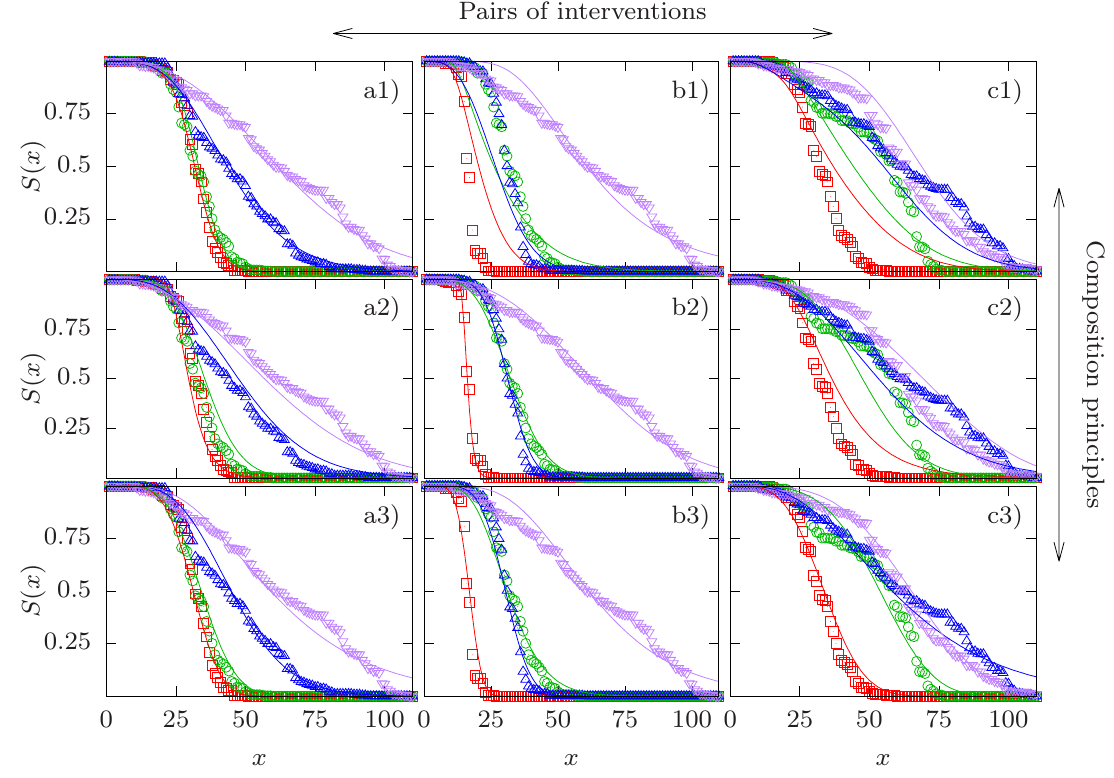
Figure 1. Comparison of experimental survival curves and model fits for three cases. Experimental survival curves are depicted by symbols and their respective fits by lines. Columns correspond to different pairs of interventions and rows correspond to different composition principles (CPs). Column a) shows the quadruple 1000 – 1011 , column b) the quadruple 0010 – 1011 , and column c) the quadruple 1010 – 1111 . Row 1) shows the competing risks CP, row 2) shows the generalized multiplicative CP, and row 3) shows the generalized scaling CP. Red squares represent the baseline curve, green circles and blue upward triangles display the two single interventions in the order of their position in the binary string (green circles first, blue upward triangles second), and purple downward triangles correspond to the combined interventions. The fits in panels a1), b2) and c3) have the best quality in their respective column in terms of their sum of squared deviations D defined in (16). The relative SSDs of the three best fits are D / D ind = 0.834 (a1), 1.06 (b2) and 1.06